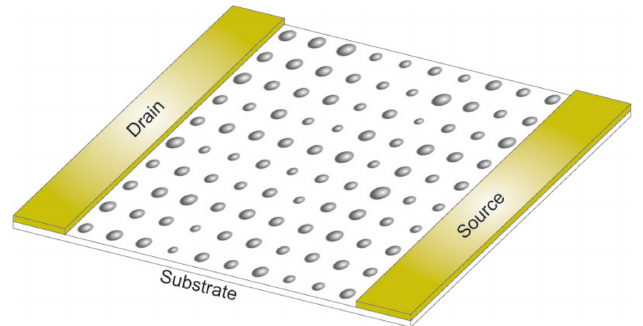
Figure 1. Schematic diagram of 2D arrays of palladium nanoparticles between source and drain electrodes.